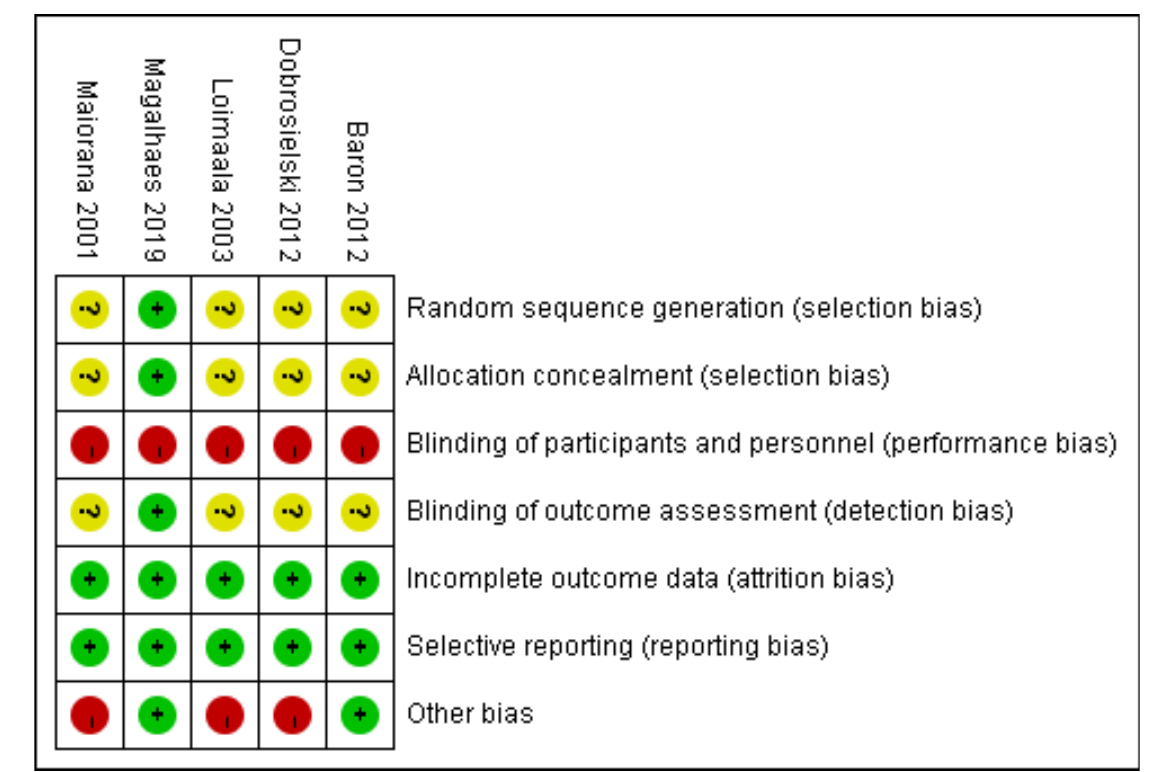
Figure 2. Risk of bias of each included study [35 – 39]. +: low risk; -: high risk; ?: unclear risk.